Question: Write a single sentence explaining what this figure depicts.
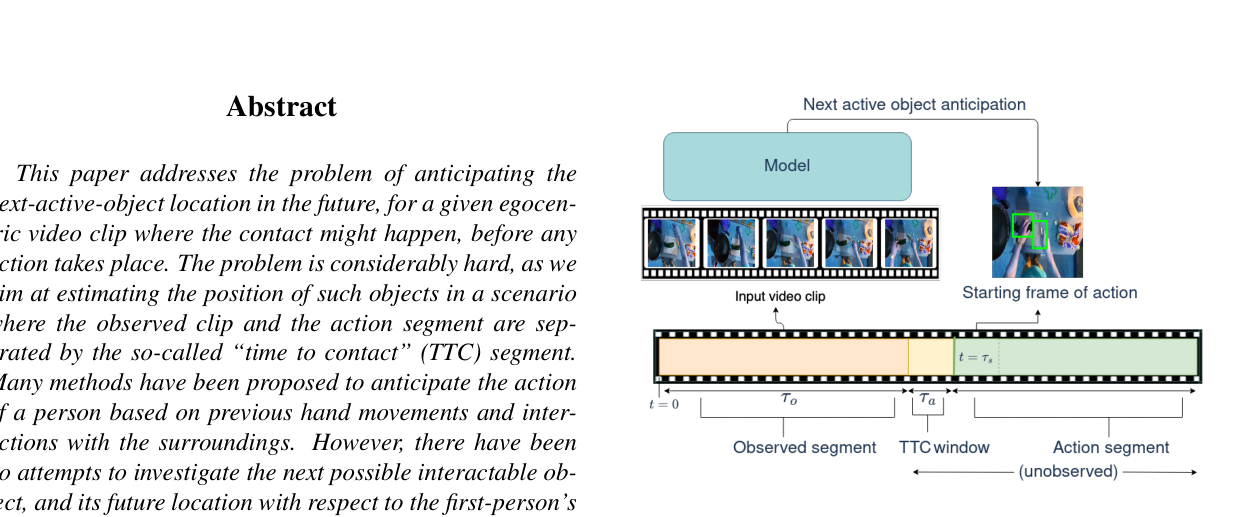
Answer: The goal of our work is to anticipate the next-active- object, i.e. to localize the object that the person will interact with in the first frame of an action segment, based on the evidence of video clip of length τo, located τa seconds (anticipation time) be- fore the beginning of an action segment at time-step t = τs.